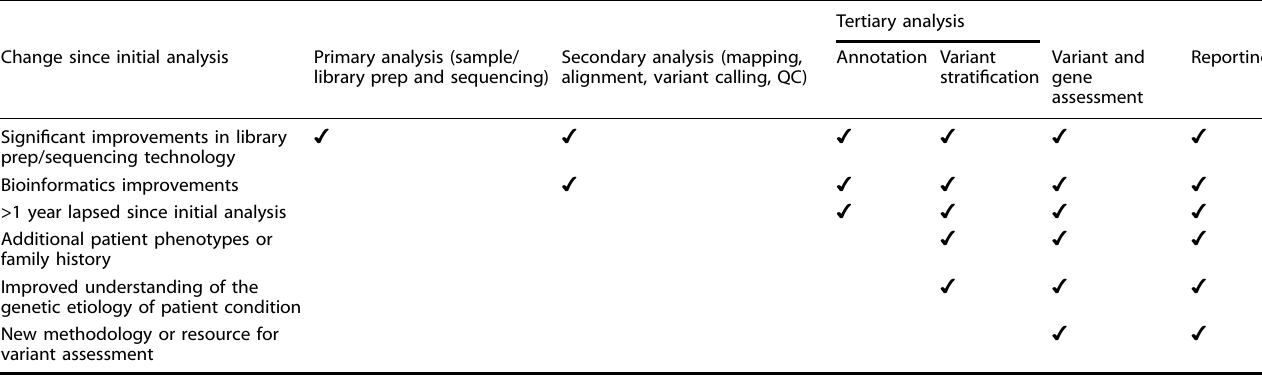
Table 2. Suggested steps of reanalysis based on events that have occurred since initial